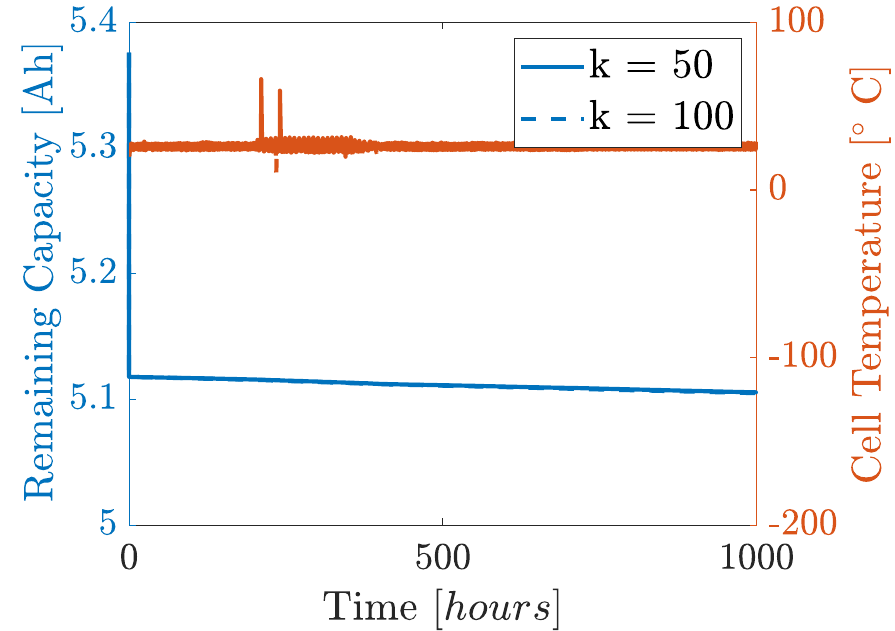
Figure 13. Advanced SoC: Effect of the gain k on Battery 1.